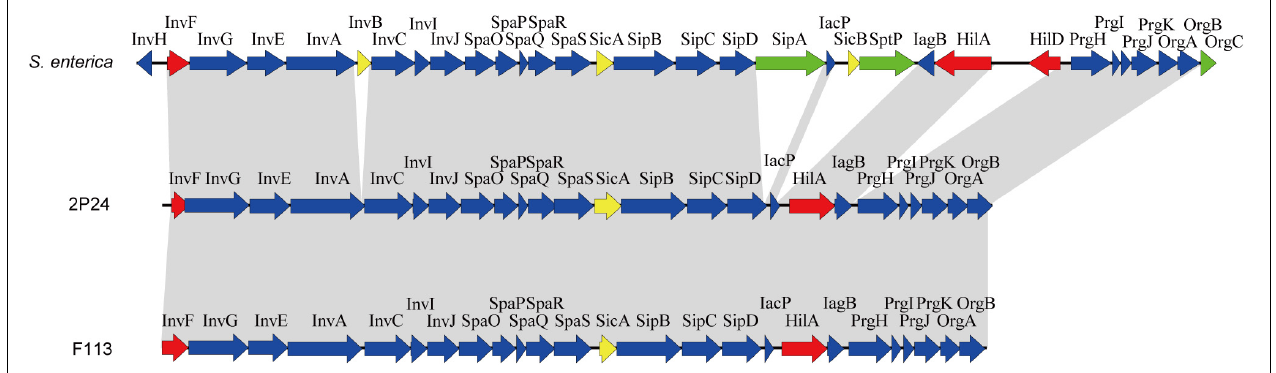
FIGURE 1 | Genetic organization of the SPI-1 T3SS cluster of P. fluorescens 2P24 and comparison with the clusters of Salmonella enterica and P. kilonensis F113. Predicted open reading frames and their orientation are shown by large arrows. T3SS accessory protein encoding genes are shown as blue arrows, transcriptional regulator encoding genes are shown as red arrows, effector protein encoding genes are shown as green arrows, and chaperone protein encoding genes are shown as yellow arrows. Homologous genes are connected with gray shading. TABLE 2 | Comparison of SPI-1 T3SS cluster proteins in P. fluorescens group and S. enterica . Length of predicted peptides (a.a.) in the following strains/percentage identity to that of strain 2P24 Length of predicted